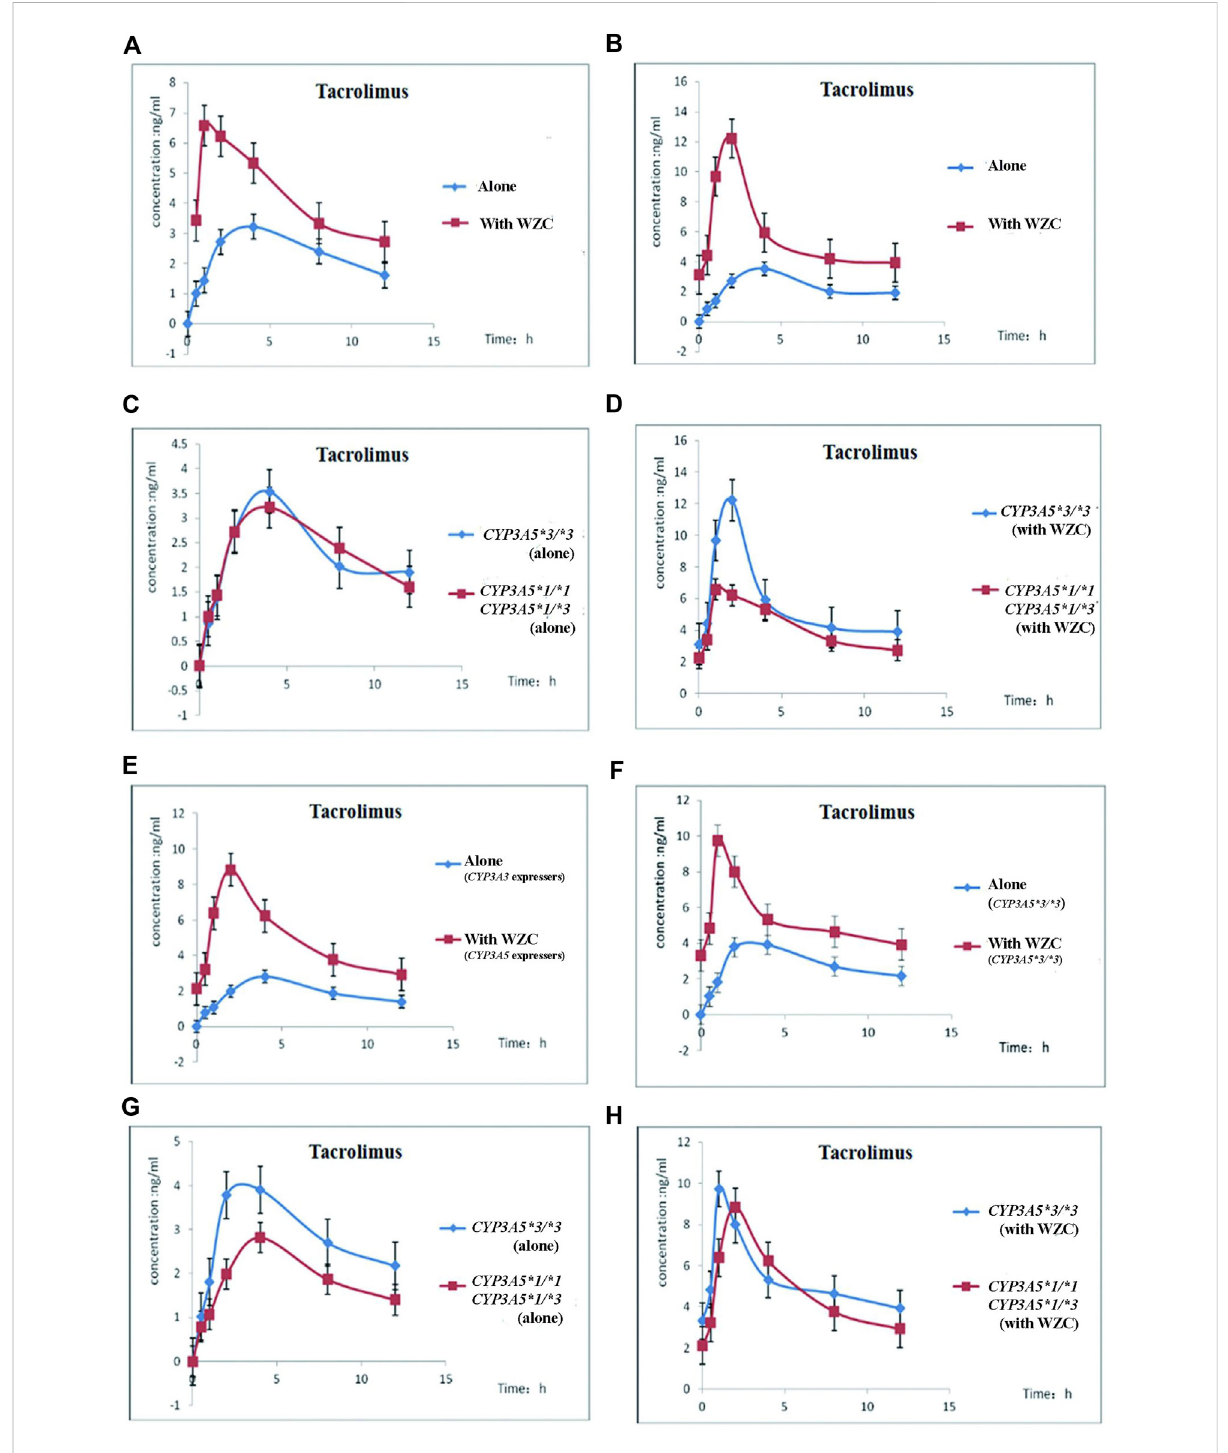
FIGURE 2 The blood concentration vs. time curves of tacrolimus in different CYP3A5 genotype donors and recipients before and after taking WZC. (A) Mean blood concentration – time curves of tacrolimus before and after taking WZC in CYP3A5*1/*1 or CYP3A5*1/*3 donors ( n = 15); (B) Mean blood concentration – time curves of tacrolimus before and after taking WZC in CYP3A5*3/*3 donors ( n = 15); (C) Mean blood concentration – time curves of tacrolimus between (CYP3A5*1/*1 or CYP3A5*1/*3) and CYP3A5*3/*3 donors when taking tacrolimus alone ( n = 15); (D) Mean blood concentration – time curvesoftacrolimus between(CYP3A5*1/*1 or CYP3A5*1/*3) and CYP3A5*3/*3donors whentaking tacrolimuscombined with WZC ( n = 15); (E) Mean blood concentration – time curves of tacrolimus before and after taking WZC in CYP3A5*1/*1 or CYP3A5*1/*3 recipients ( n = 15); (F) Mean blood concentration – time curves of tacrolimus before and after taking WZC in CYP3A5*3/*3 recipients ( n = 15); (G) Mean blood concentration – time curves of tacrolimus between (CYP3A5*1/*1 or CYP3A5*1/*3) and CYP3A5*3/*3 recipients ( n = 15); (H) Mean blood concentration – time curves of tacrolimus between (CYP3A5*1/*1) or CYP3A5*1/*3) and CYP3A5*3/*3 recipients after taking WZC ( n =